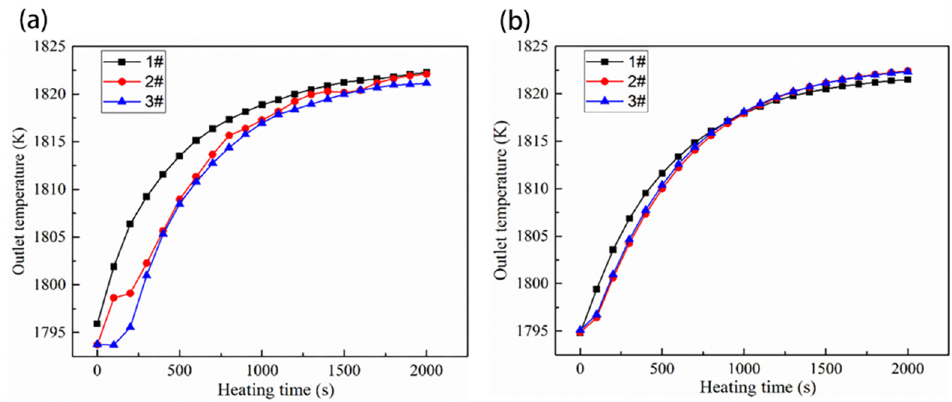
Figure 21. Temperature rising curve of tundish outlets against heating time: ( a ) S0; ( b ) FK-A0.